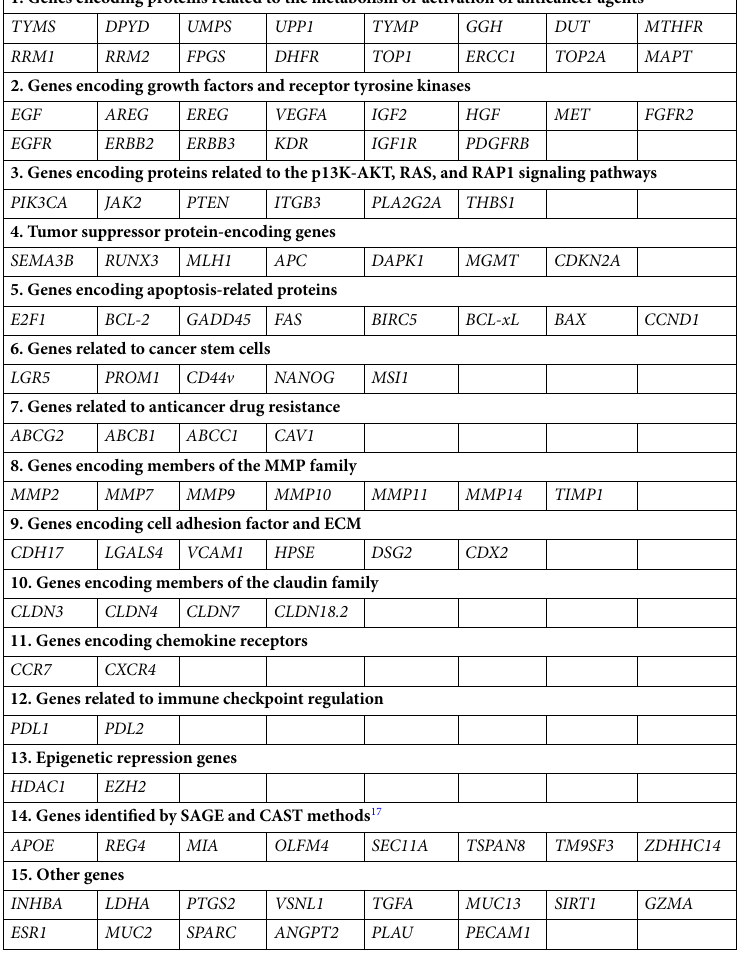
Table 4. Genes investigated (n =